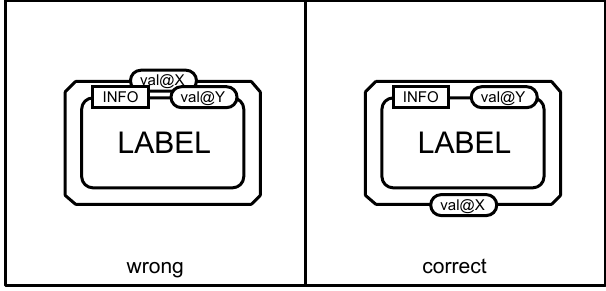
Figure 4.8: Units of information should not overlap with any other